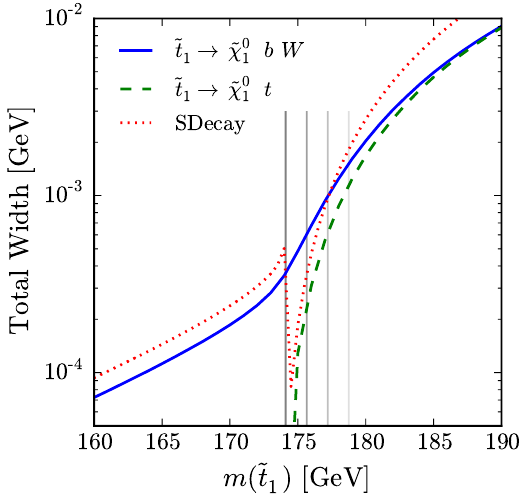
Figure 3 . The total width of a right handed stop computed assuming m t = 173.1 GeV and m (~ (cid:31) 0 ) = 1 GeV. The solid blue and dashed green lines are computed with MadGraph , by forcing 1 a two- and three-body decay respectively. Clearly, the two-body approach does not capture near threshold e(cid:11)ects (which can be important with multiple widths of the top as denoted by the thin vertical lines), due to the phase space factor implicit in the two-body assumption. For reference, we also show a comparison with SDecay in the red dot-dashed line, since it includes loop corrections from QCD. However, clearly SDecay is not reliable near